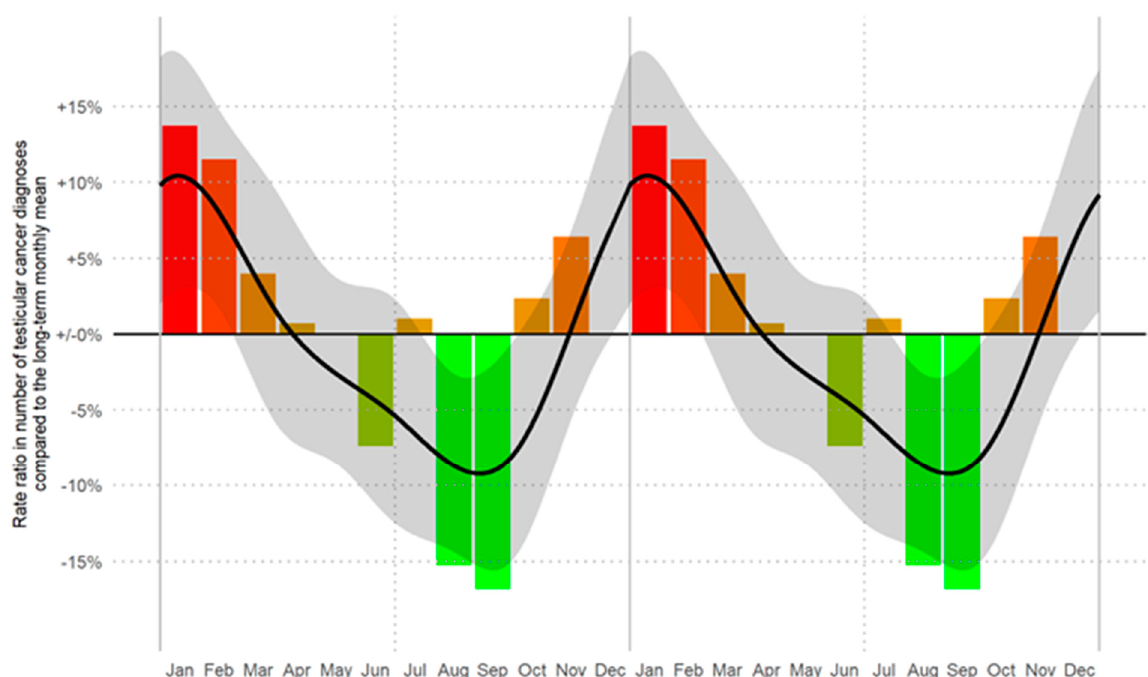
Figure 1. Rate ratios (RRs) of the number of TGCT diagnoses by month of diagnosis. Crude RRs (corrected for the length of the respective month) are displayed as bars. The smoothed RR curve, modelled via natural cubic splines, is overlaid in black together with 95% confidence bands (shaded). A likelihood ratio test showed a significant seasonal trend ( p < 0.001). The horizontal reference line refers to the long-term (time period between 2008 and 2018) monthly average number of diagnoses of 27.4 cases/month (RR = 1.00). Data are displayed as a double plot for better visualization of the seasonal trend. From red to green in descending order of RRs.